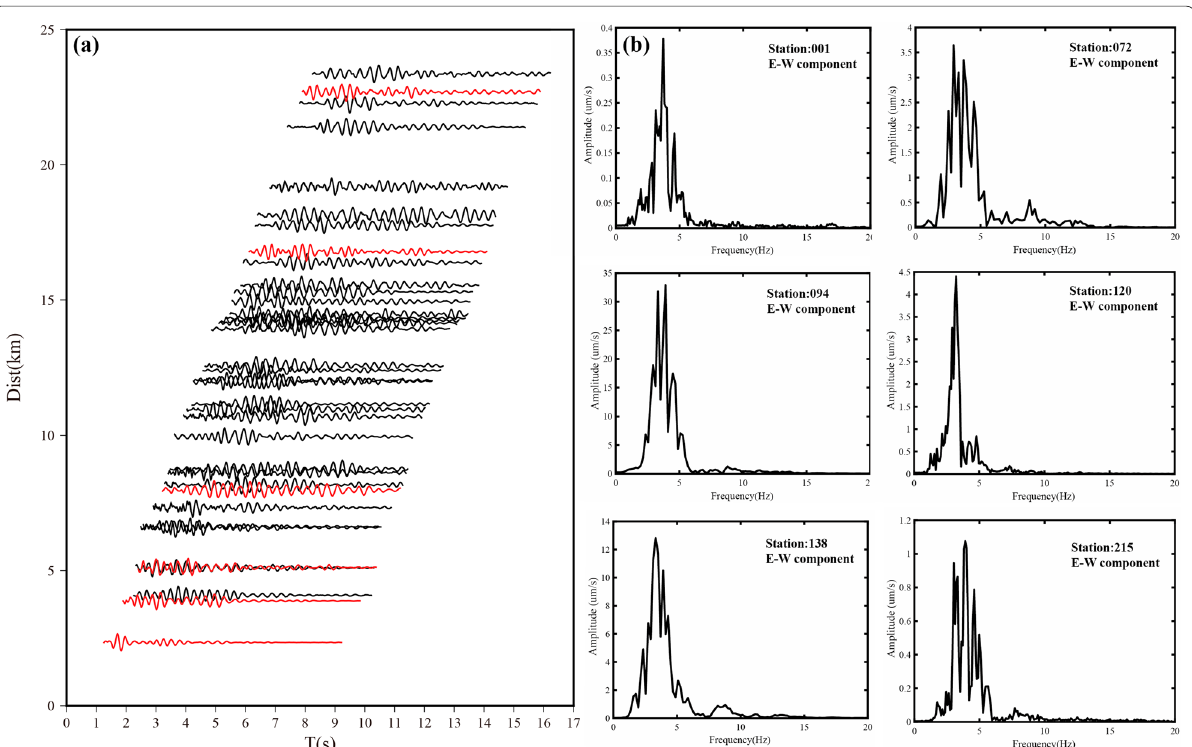
Fig. 5 Amplitude spectra of six stations. The waveform in an 8-s time window starting from the onset of S wave is shown on the left, and the amplitude spectra of six stations is displayed on the right. The waveform of the amplitude spectra in b is indicated in red in